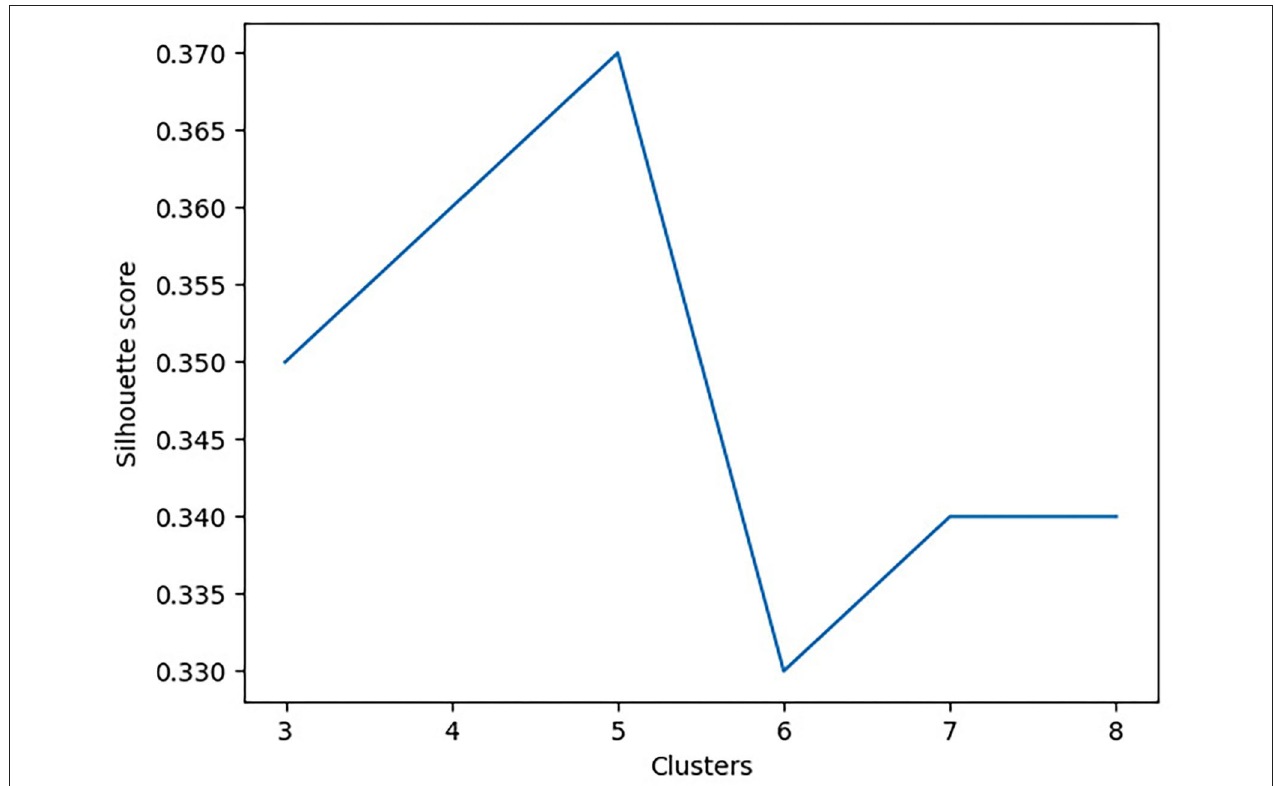
FIGURE 1 | The Silhouette score as a function of the number of